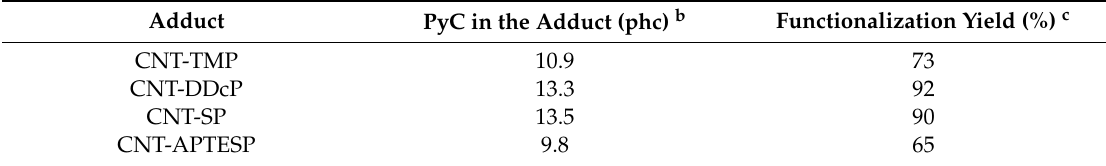
Table 2. Yield of functionalization of CNTs with PyC a .